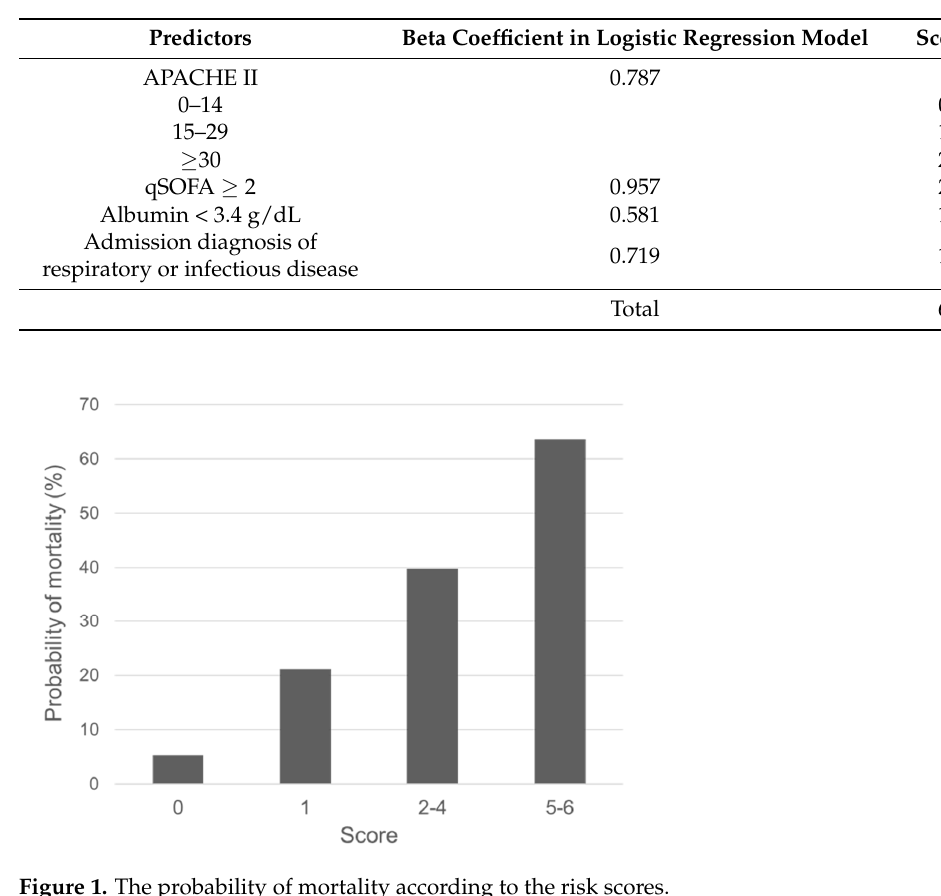
Table 3. Mortality risk scoring system.